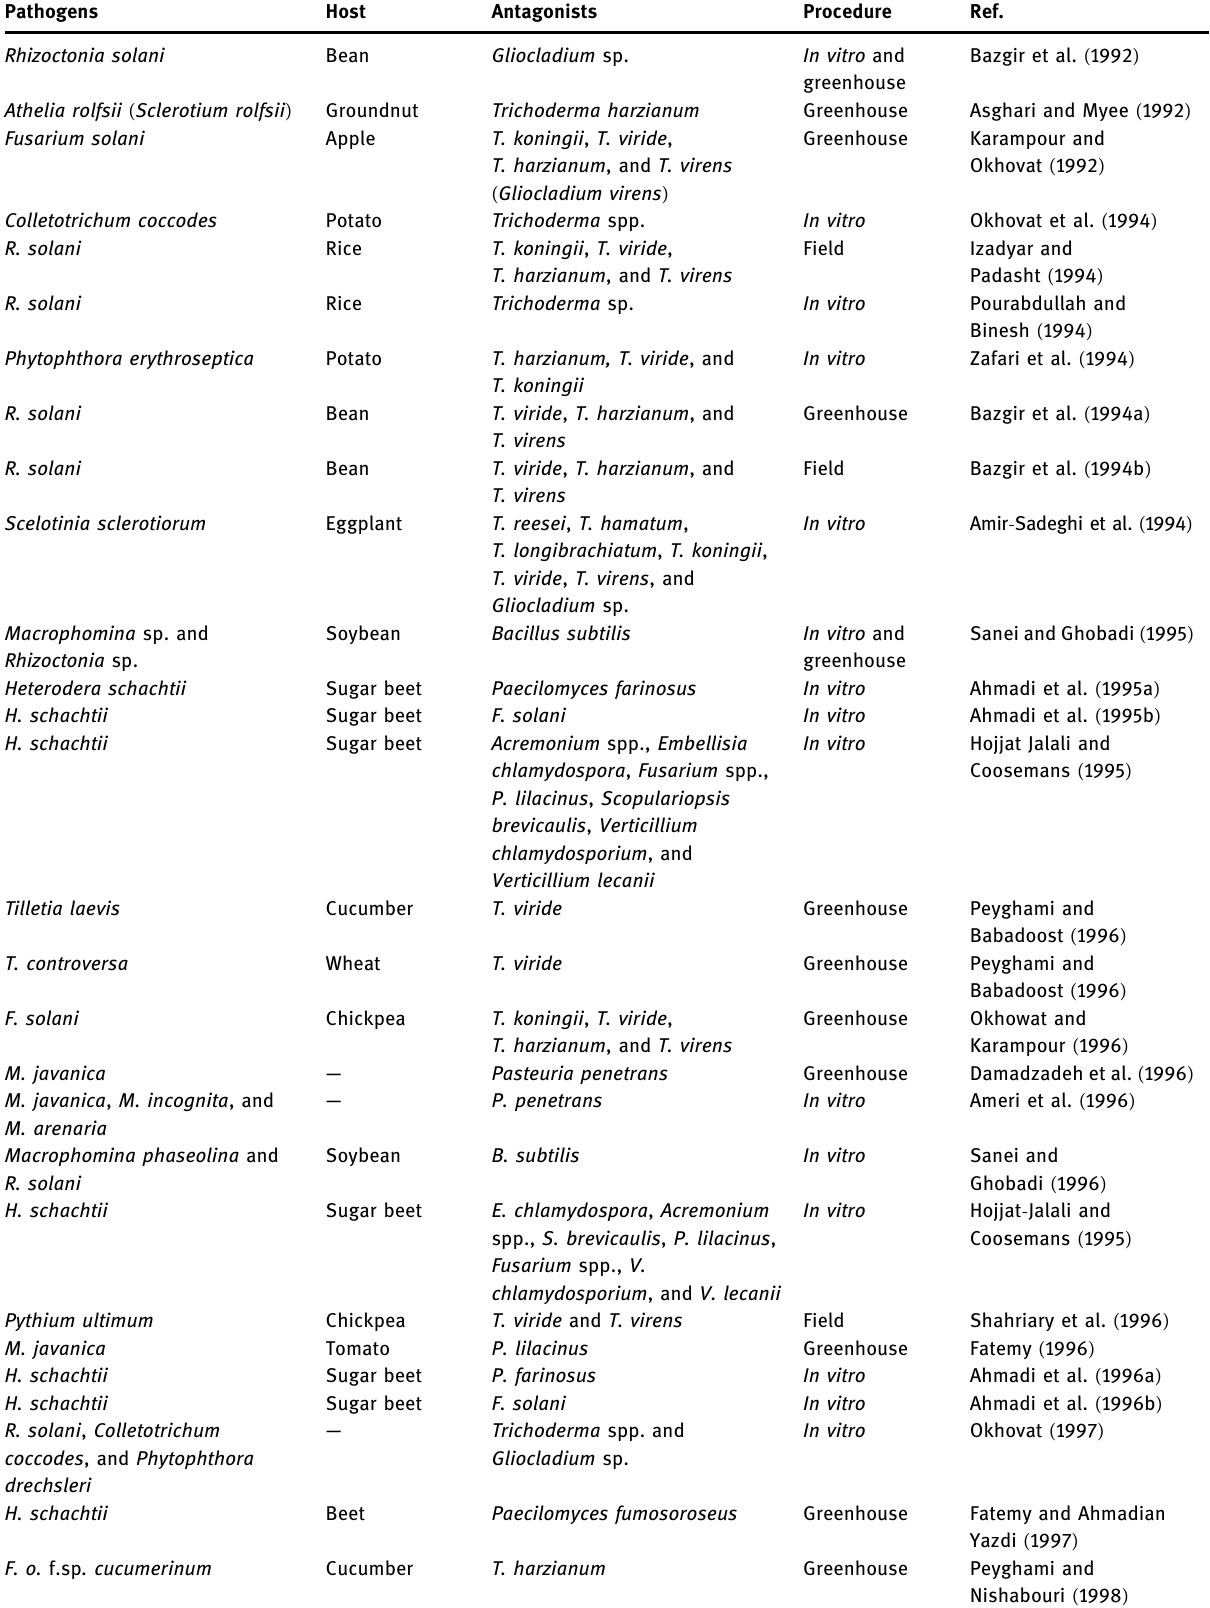
Table 1: List of pathogens, hosts, and antagonists with procedures based on published research works in Iran from 1992 to 2018 Pathogens Host